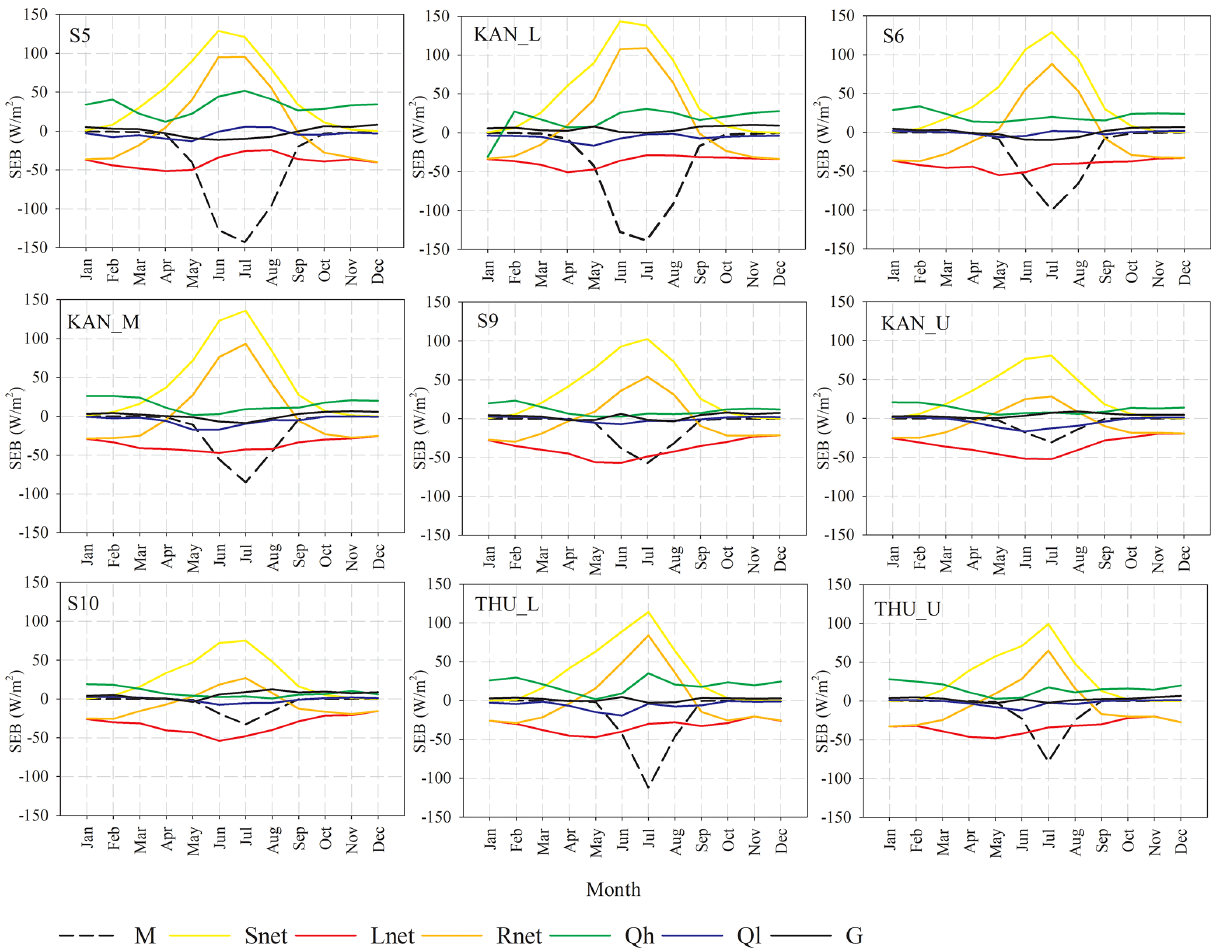
Figure 9. Multiyear average seasonal cycle based on monthly means of SEB